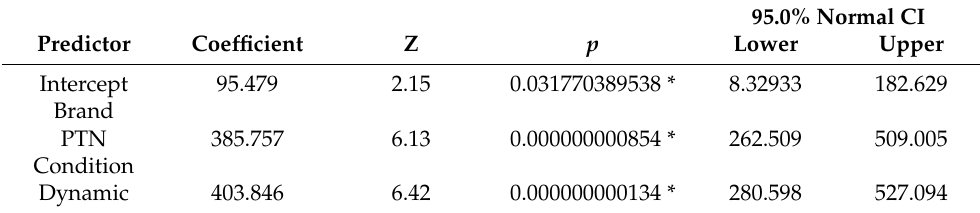
Table 6. Regression table for brand and condition of rotation.